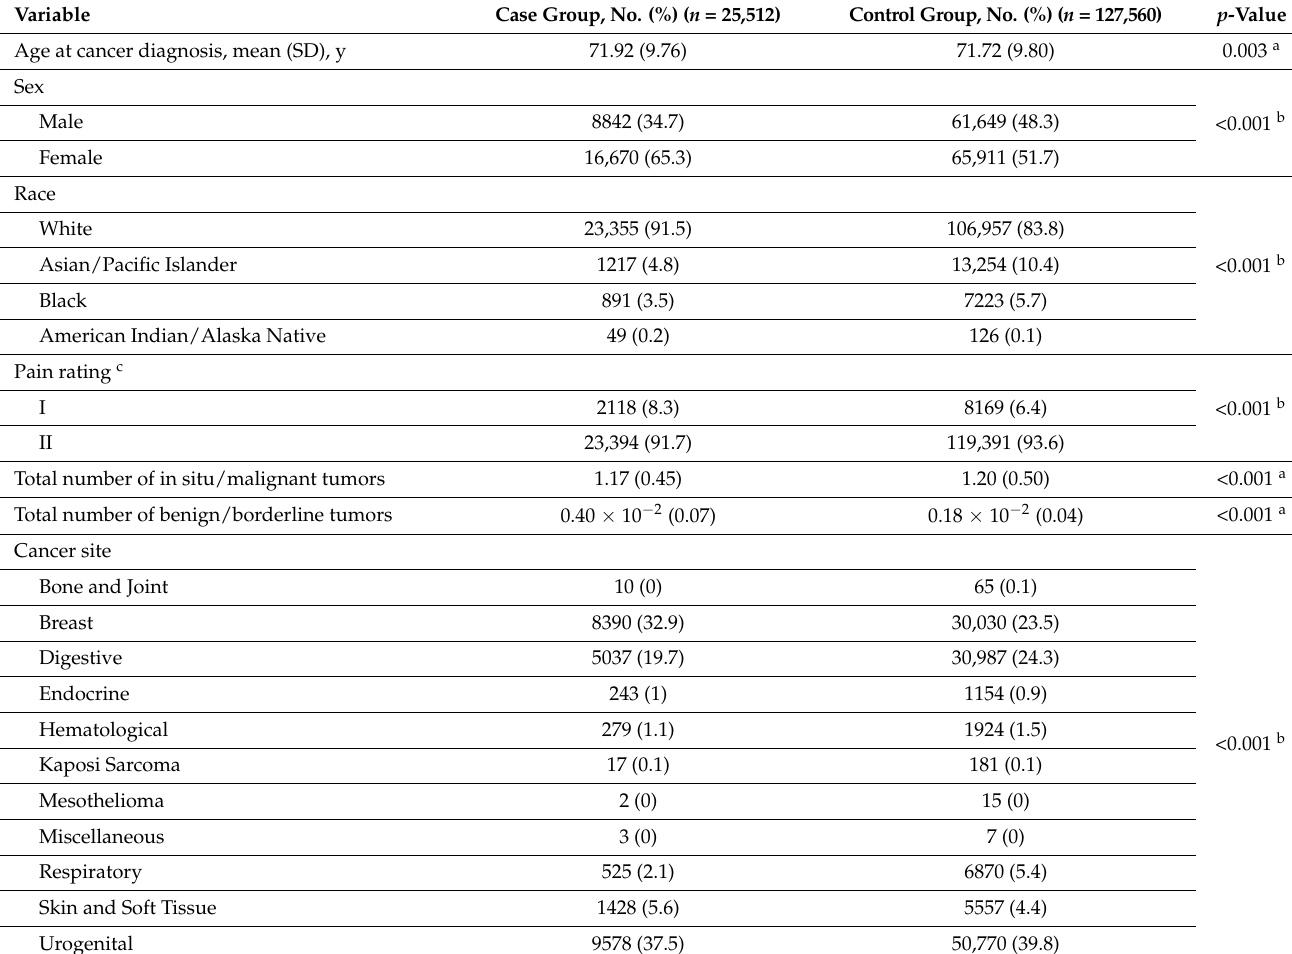
Table 1. Baseline characteristics of cases and